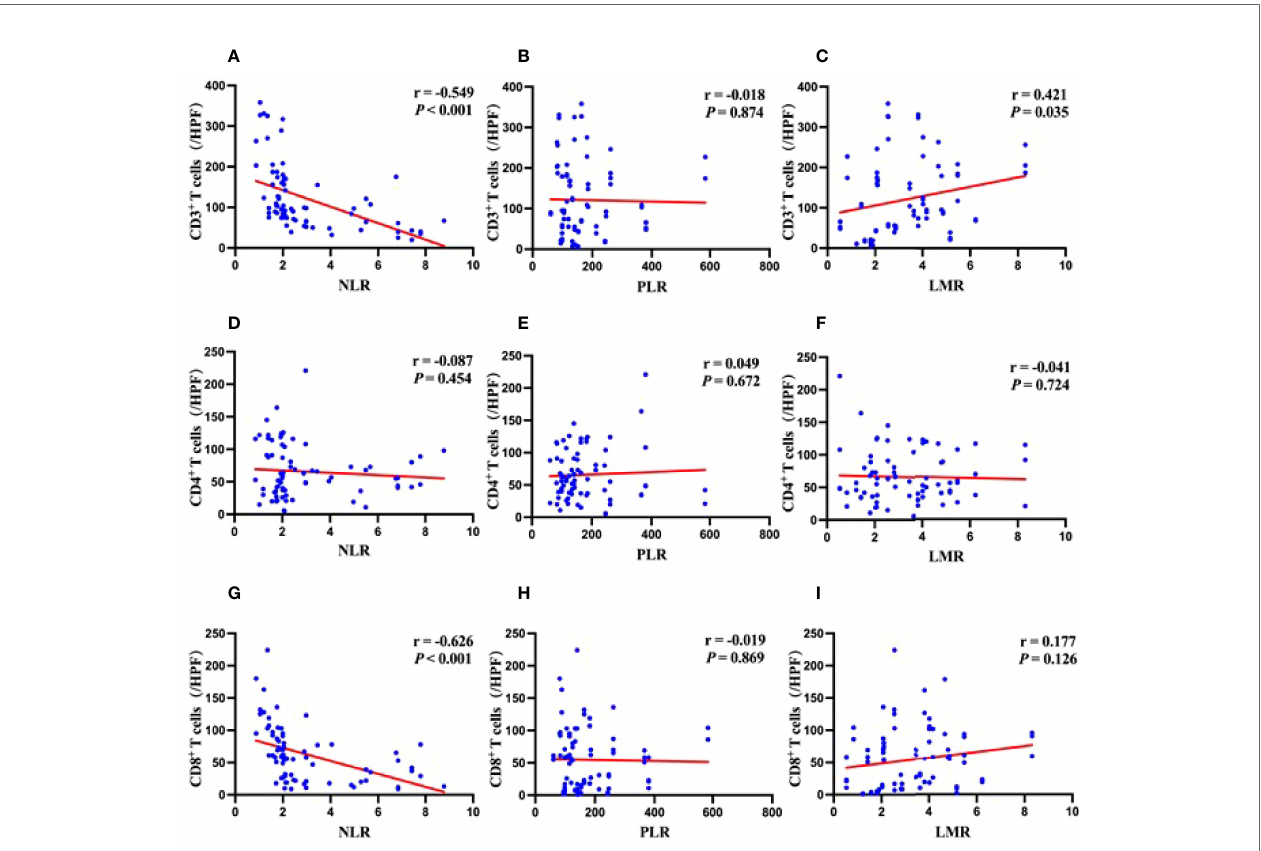
FIGURE 3 | Correlations between systemic in fl ammation markers and density of immune cells in the tumor microenvironment. (A) Correlation between NLR and levels of CD3 + T cells in fi ltration. (B) Correlation between PLR and levels of CD3 + T cells in fi ltration. (C) Correlation between LMR and levels of CD3 + T cells in fi ltration. (D) Correlation between NLR and levels of CD4 + T cells in fi ltration. (E) Correlation between PLR and levels of CD4 + T cells in fi ltration. (F) Correlation between LMR and levels of CD4 + T cells in fi ltration. (G) Correlation between NLR and levels of CD8 + T cells in fi ltration. (H) Correlation between PLR and levels of CD8 + T cells in fi ltration. (I) Correlation between LMR and levels of CD8 + T cells in fi